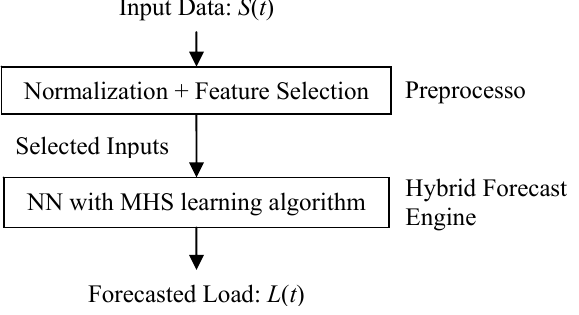
Figure 1. Structure of the proposed STLF strategy including the preprocessor and hybrid forecast